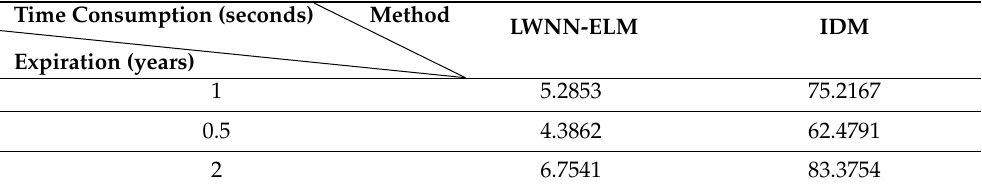
Figure 2. Comparison of the solution at α = 1 with the traditional B-S model, where the corresponding parameters are σ = 0.45, r = 0.03, q = 0.01, K = 10, A = 3, B = 15, and M = 16. ( a ) T = 1 (years); ( b ) T = 0.5; ( c ) T = 2. Table 1. Time consumption of the LWNN-ELM and IDM for different